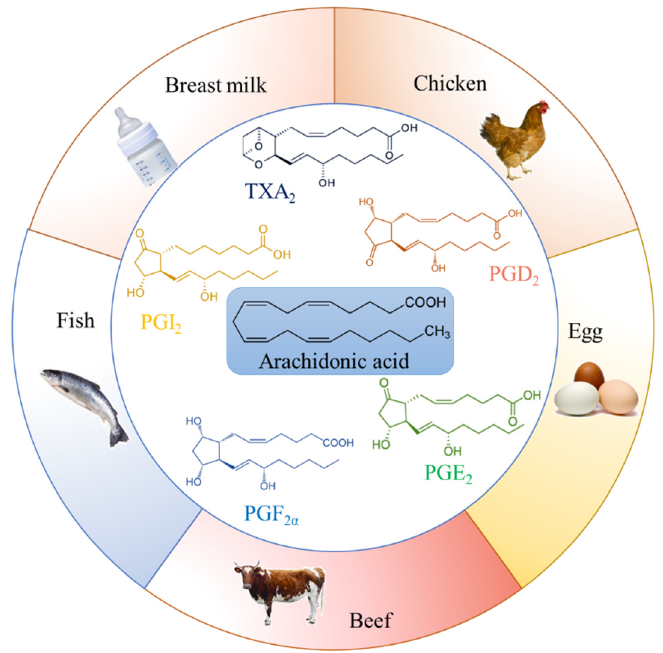
Figure 1. Food items rich in arachidonic acid. Chicken and chicken-mixed dishes, eggs, beef and beef products, pork and pork products, invertebrates and fish, breast milk and infant formula milk powder provide the most arachidonic acid intake to humans. Prostaglandin (PG)D 2 , PGE 2 , PGF 2 α , prostacyclin (PGI 2 ), and thromboxanes (TX)A 2 are major arachidonic acid metabolites. These polyunsaturated fatty acids play an important role in their growth and reproduction.